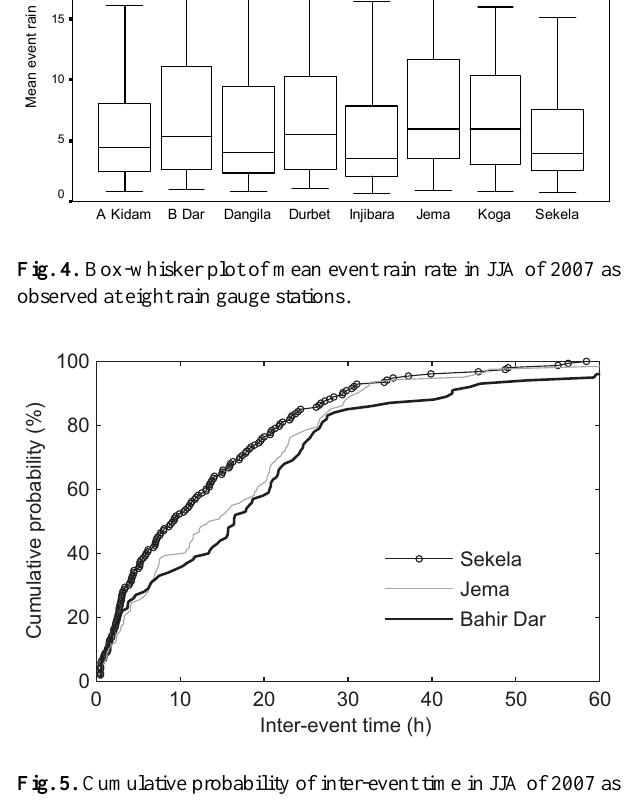
Fig. 5. Cumulative probability of inter-event time in JJA of 2007 as Fig. 5 Cumulative probability of inter-event time in JJA of 2007 as observed at three 754 observed at three rain gauge rain gauge stations. 755